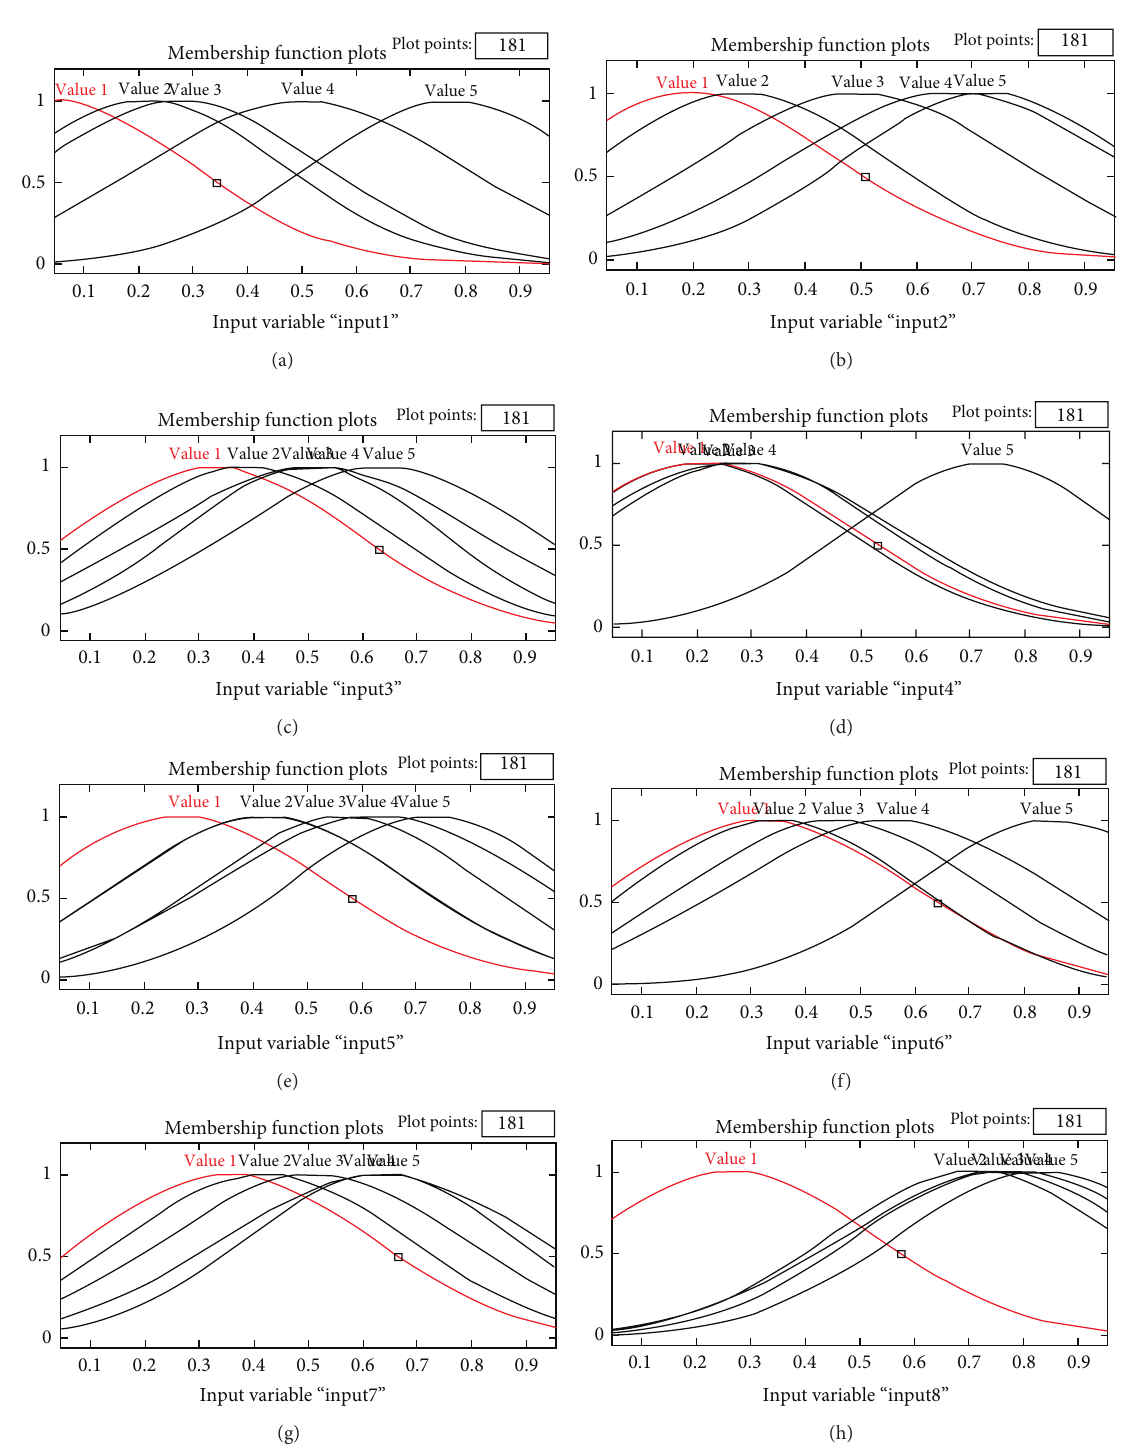
Figure 8: Fuzzy membership functions of the affections of mobile phone: (a) top shape, (b) bottom shape, (c) function button shape, (d) layout, (e) body length, (f) body thickness, and (g) border